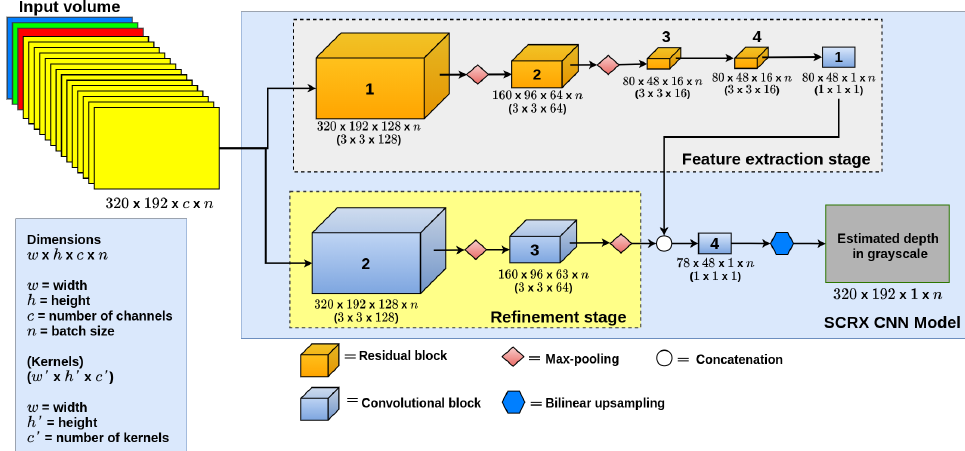
Figure 5. SCRX CNN